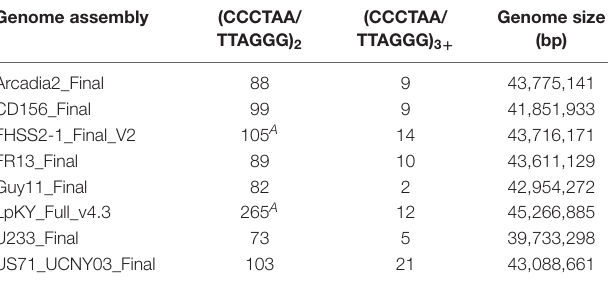
TABLE 1 | Telomere motifs in the genome